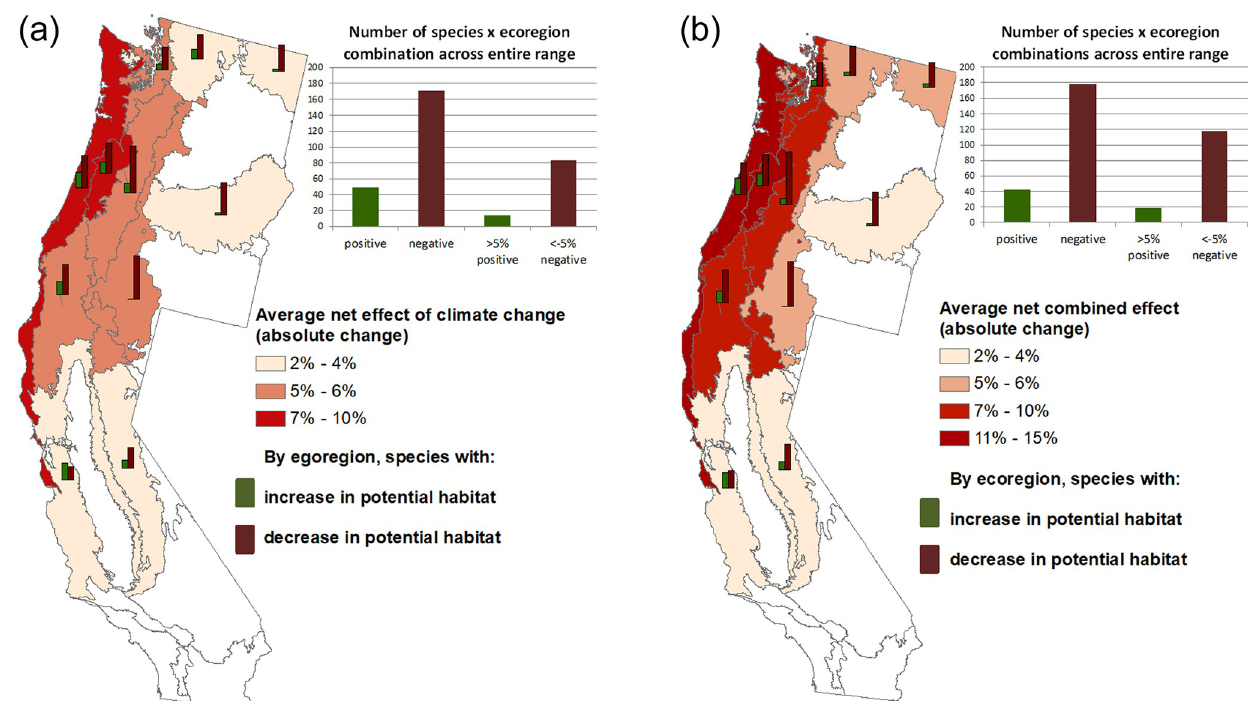
Fig 4. Modeled effects of climate change and carbon pricing on potential habitat of wildlife species, by ecoregion. The bar graphs within the maps show, for each ecoregion, the number of species positive change in potential habitat (green) and the number of species with negative change in potential habitat (brown). Changes in both a) and b) are relative to the baseline scenario. The bar graphs on the top right of each map show, in the 2 left bars, the total number of positive or negative species-ecoregion changes (the sum of all the bar graphs within each map). The two right bars show a subset of the species- ecoregion changes: “ > 5% positive” includes the species in an ecoregion that gain > 5% potential habitat by 2100 relative to the baseline, and “ > 5% negative” includes the species in an ecoregion that lose > 5% potential habitat by 2100 relative to the baseline (5% was chosen to represent changes of more practical significance). The maps and bar graphs were created by the authors with the ArcMap software [41]. a. Effects of climate change. b. Effects of climate change + carbon pricing.